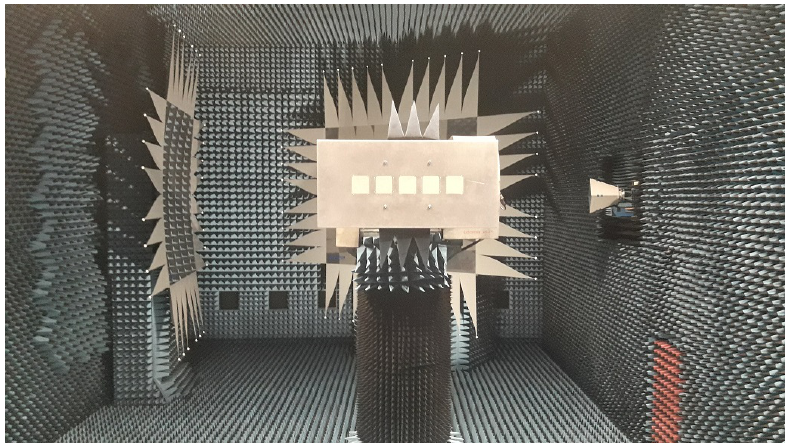
Figure 6. Picture of the antenna array in the DLR’s Compact Test